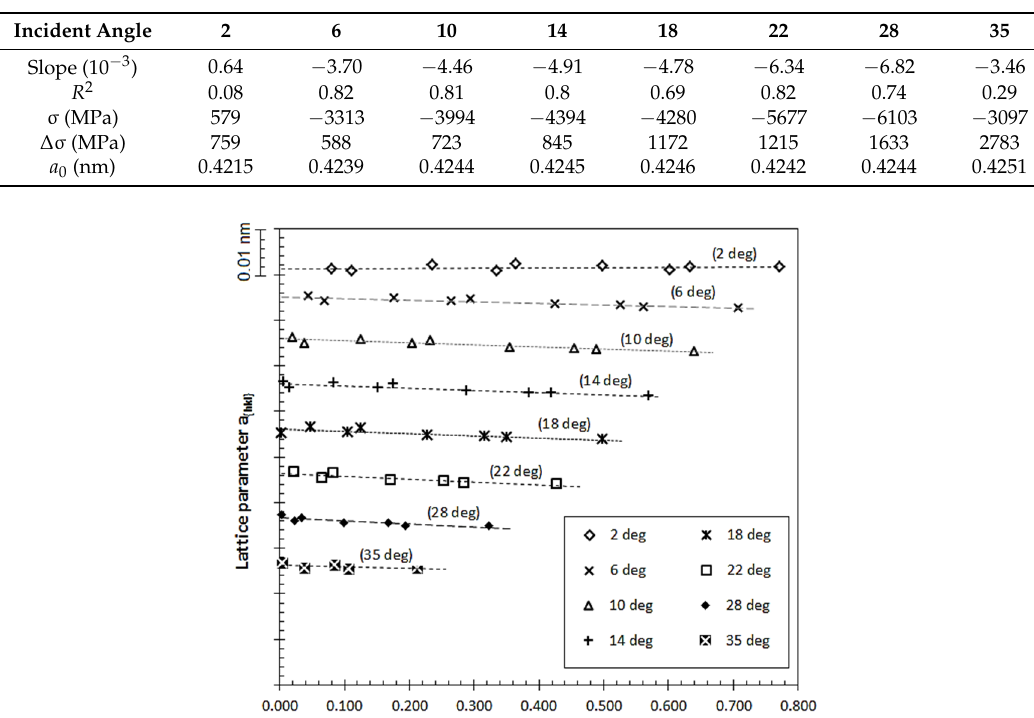
Table 4. Results of calculations at the glancing incident (GIXRD) mode.